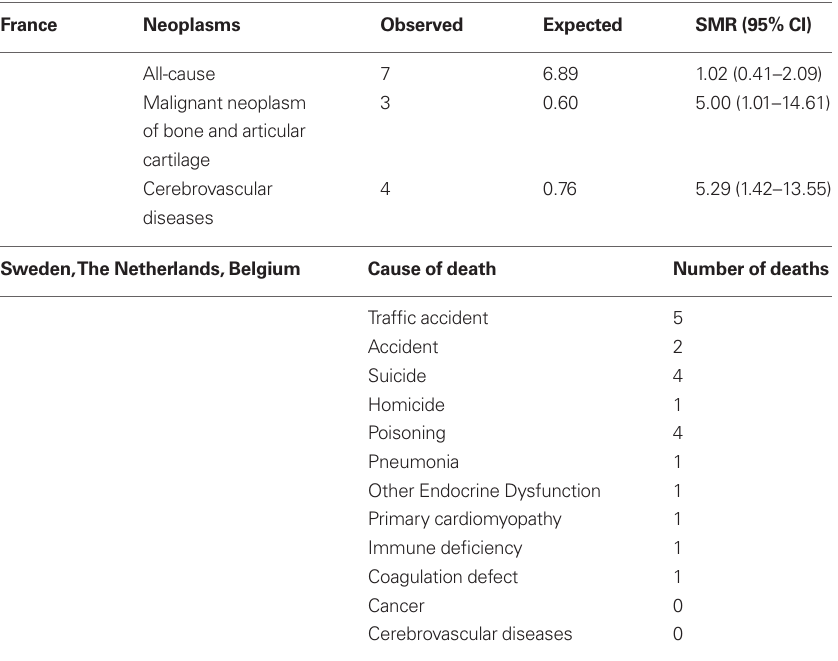
Table 1 | Preliminary data reported from SAGhE (Safety and Appropriateness of Growth hormone treatments in Europe)